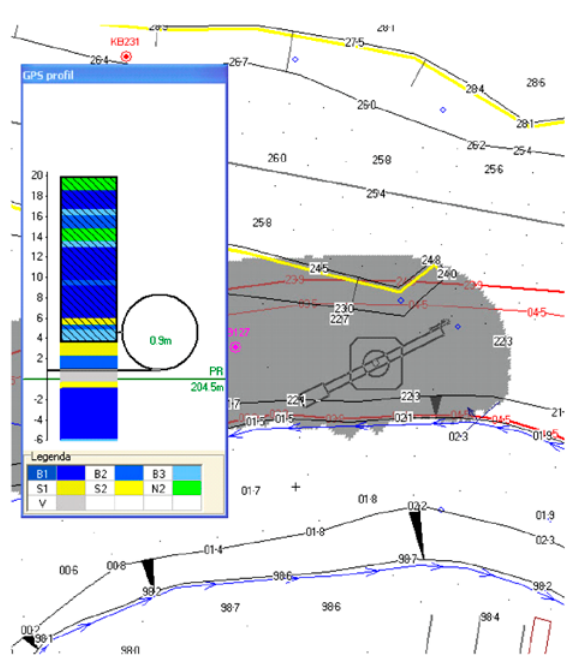
Fig. 3. The position of the bucket wheel excavator in real time (map and